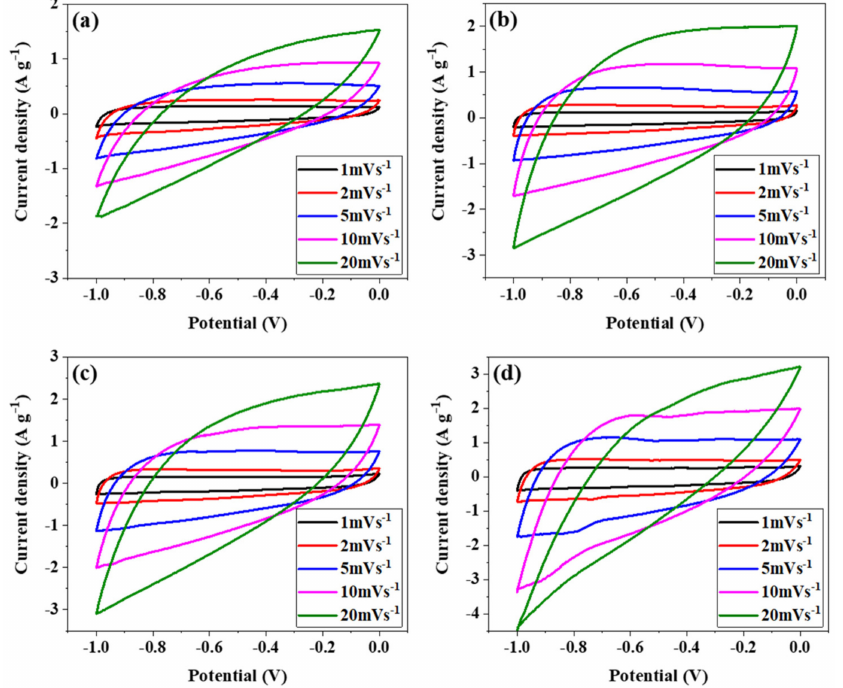
Figure 4. Cyclic voltammetry curves of the NPC ( a ), BNPC-0.05 ( b ), BNPC-0.10 ( c ) and BNPC-0.15 ( d ) at di ff erent scan